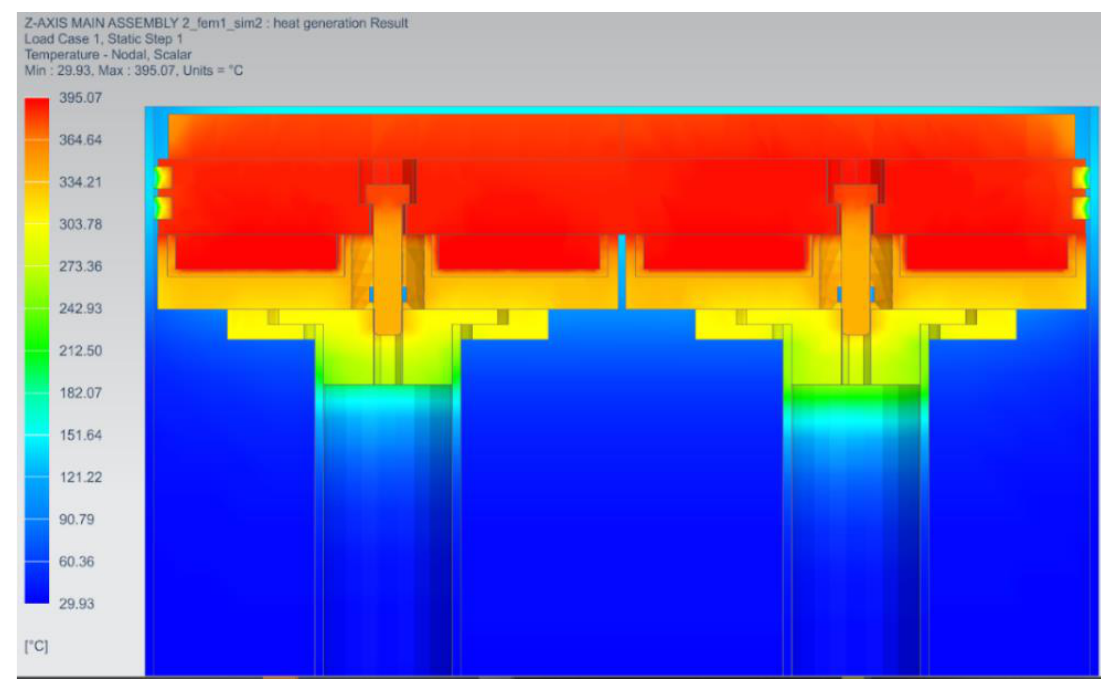
Figure 11. Steady-state analysis of the preheating system.